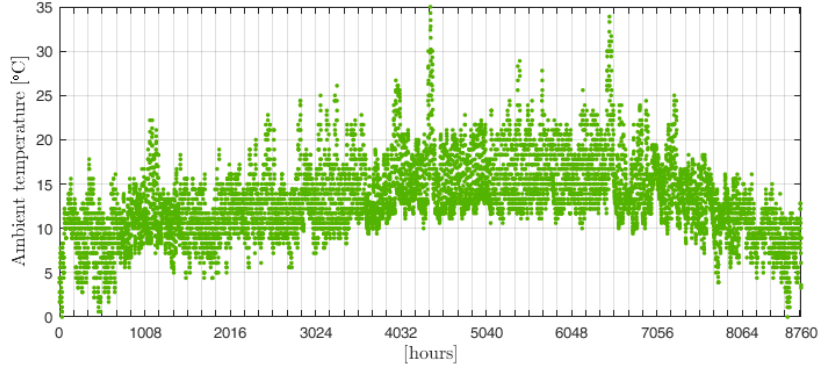
Figure 4. Energy load demand of the case study.